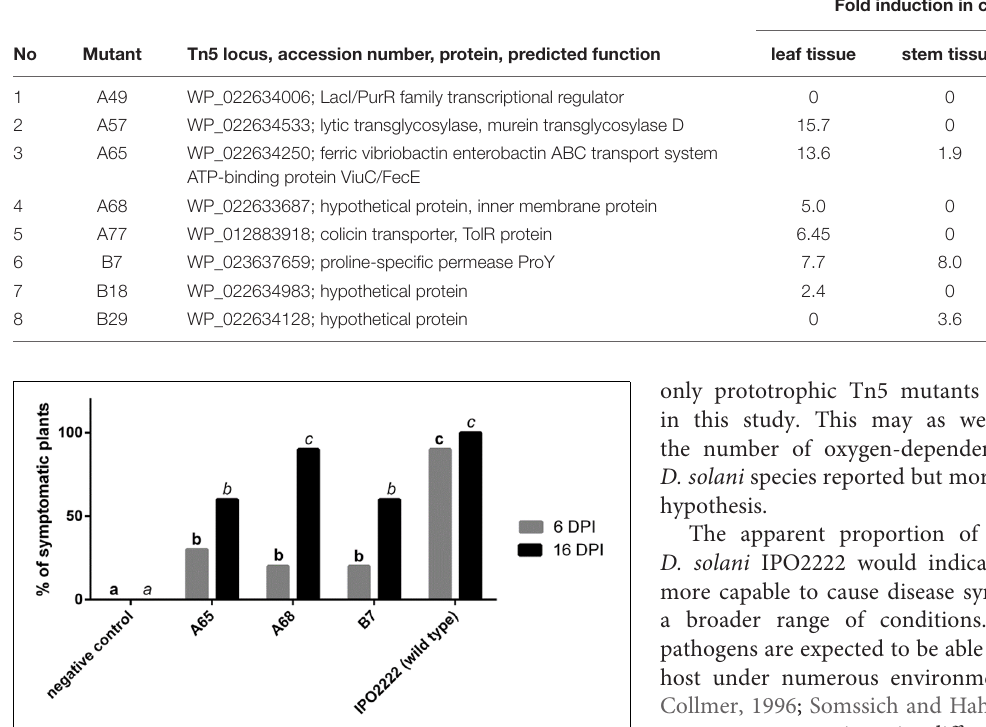
Fold induction in contact with S. tuberosum